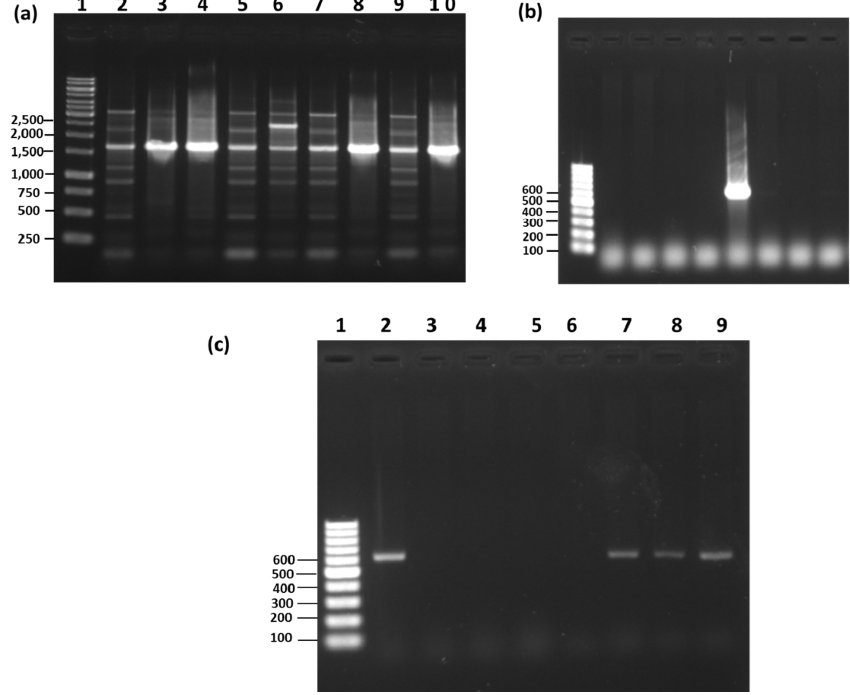
Figure 7. ( a ) RAPD-PCR of various reference strains of Bacillus licheniformis . Lane 1: 1 kb size ladder (unit: bp); Lane 2: Bacillus licheniformis ATCC21415; Lane 3: Bacillus licheniformis KCTC3056; Lane